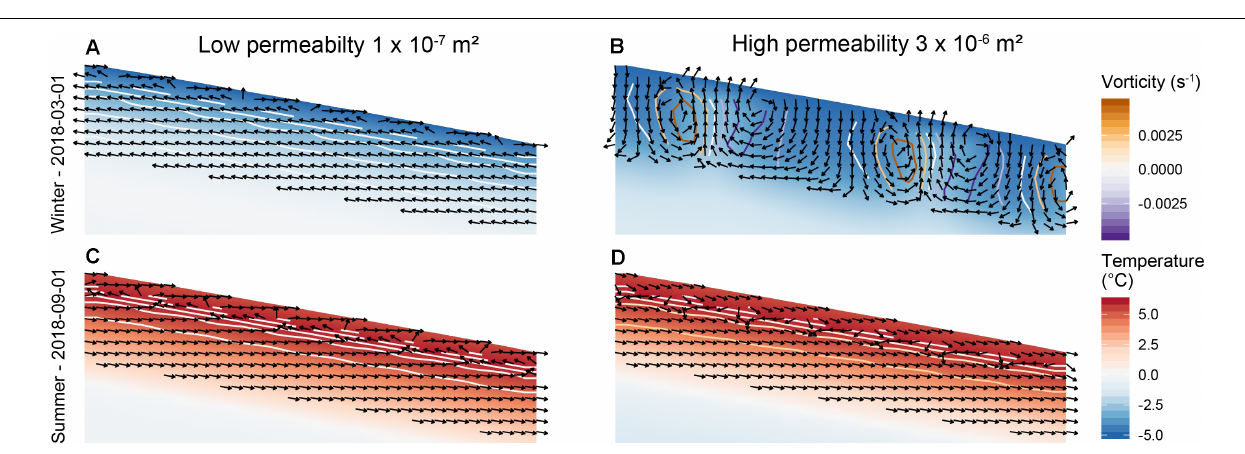
FIGURE 6 | Typical winter (A,B) and summer (C,D) circulation in the active layer of the Murtel-Corvatsch rock glacier for a low permeability of 1 × 10 − 7 m 2 (A,C) and a high permeability of 3 × 10 − 6 m 2 (B,D) . The color scheme indicates the temperatures, the colored contours the vorticity and the black arrows indicate the direction of airflow field. Note the multicellular convection pattern in panel (B) , where the vorticity is positive (negative) for counter-clockwise (clockwise) circulating cells.